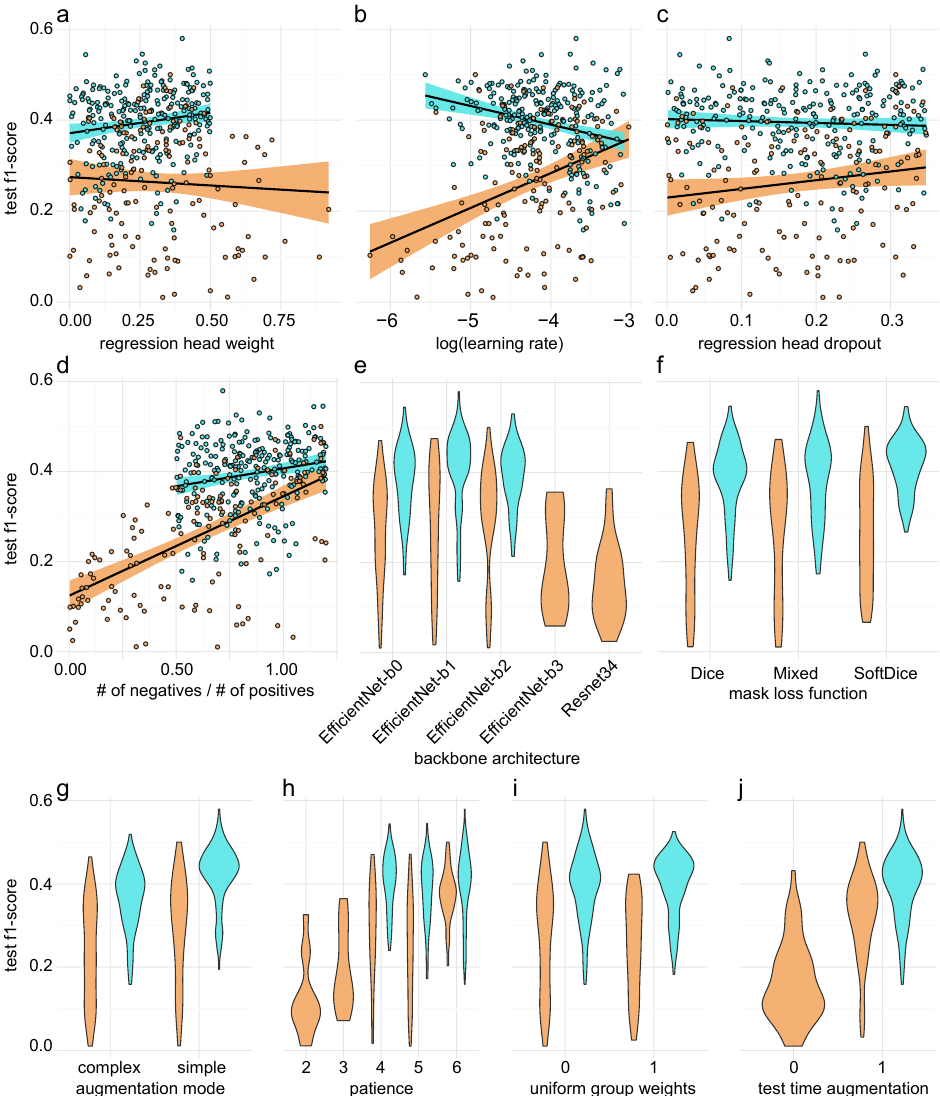
Figure 4. Results from random search hyperparameter study for semantic segmentation models, with phases one (orange) and two (teal). For continuous hyperparameters—namely, regression head weight, learning rate, regression head dropout, and negative-to-positive ratio—each circle corresponds to an independent random search experiment. For the continuous hyperparameters— regression head weight, learning rate, negative-to-positive ratio, and the discrete parameters— backbone architecture, patience, and test time augmentation, we narrowed down the range of options to speed up convergence on a best-performing model. Apart from narrowing down hy- perparameter priors, we also used phase 2 to test the potential benefit of using regression output as a post-processing step to remove potential false positives, and thus, the test f1-score for those experiments is calculated after post-processing. The width of violin shapes for categorical variables (panels e – j ) indicate the proportion of observations that take on those values, whereas X-axis values indicate all discrete states tested for that categorical variable. Phase 2 experiments tested a narrower range of discrete states for test time augmentation, patience, and backbone architecture; thus, there were no phase 2 results for some discrete states of those variables. Experiments for which test f1-score was below 0.01 are excluded from this